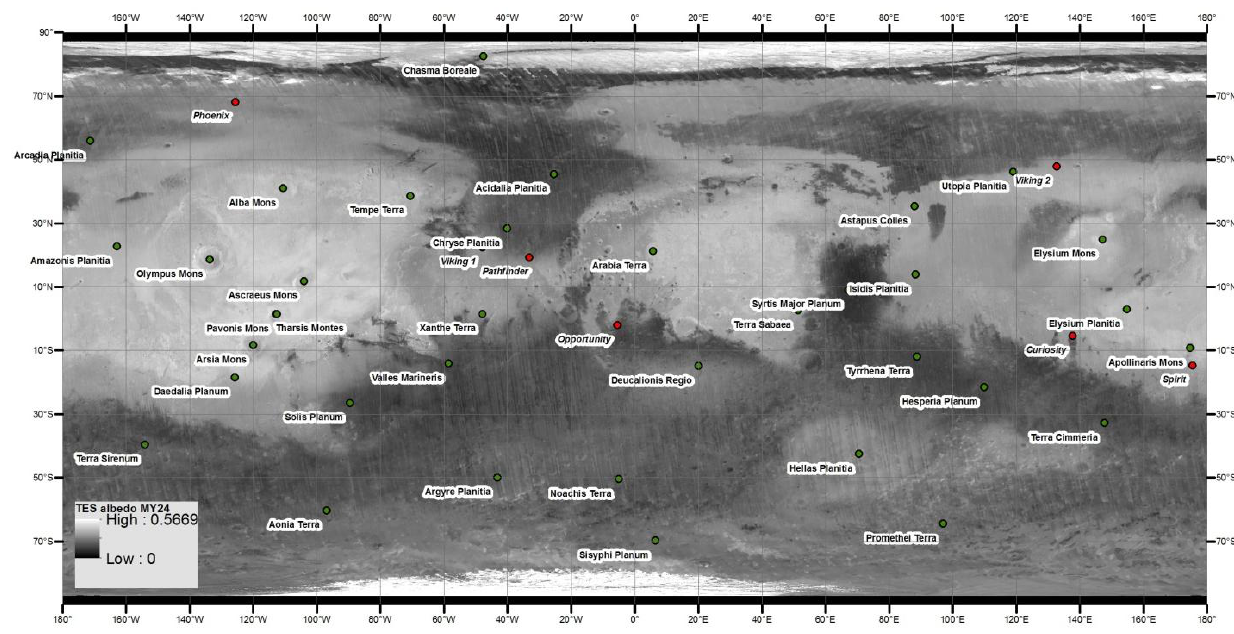
Figure A2. TES albedo data used in this study. Data sourced from